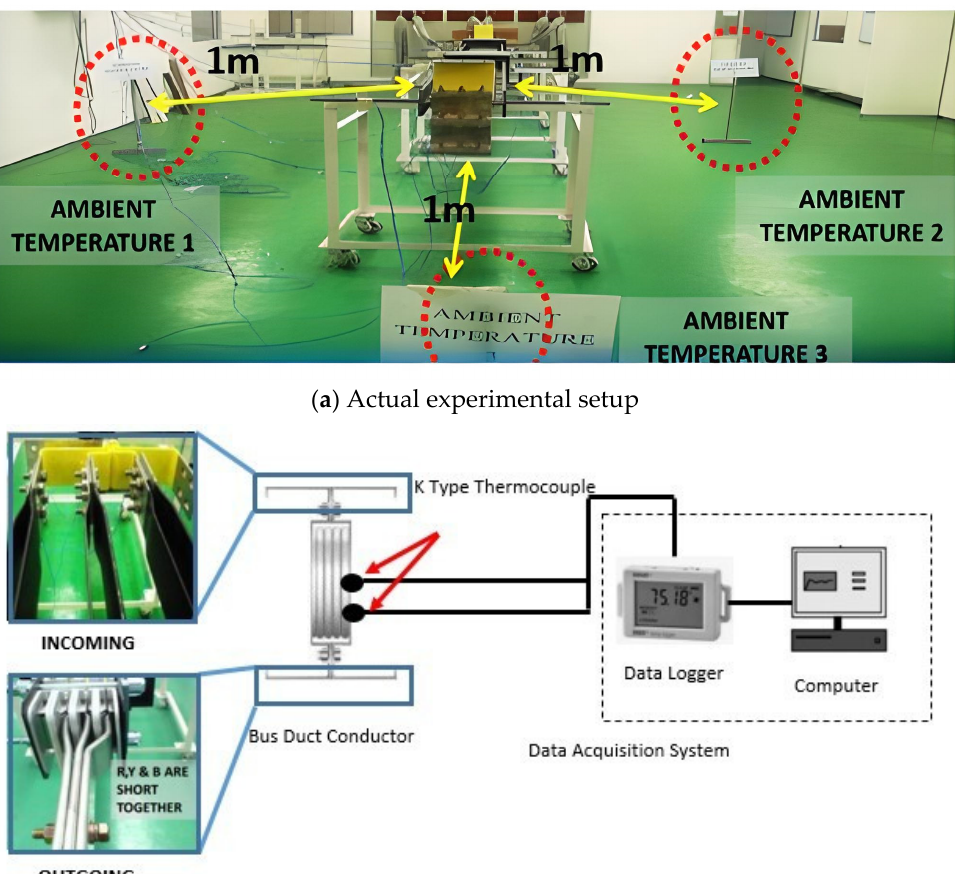
Figure 5. ( a ) Experimental setup with the surrounding air temperature measured with a K-Type thermocouple 1 m from the casing ( b ) Schematic diagram of the bus duct conductor and setup.